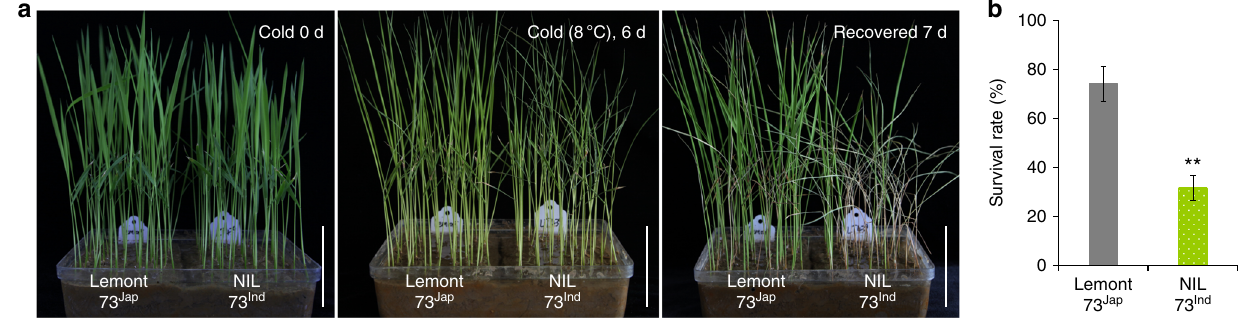
Fig. 4 Increased sensitivity of bZIP73 Ind near-isogenic lines to cold stress. a Cold treatment of bZIP73 Ind near-isogenic lines (NIL) and Lemont ( japonica ) at 8 °C for 6 days and recovery (Recovered) at 28 °C for 7 days. NIL is introgression of bZIP73 Ind into the japonica variety Lemont. b Survival rates of Lemont and NIL after recovery from cold treatment. All data were collected with three biological replicates ( n = 120 each). Error bar, standard deviation. Scale bars, 5 cm; ** p < 0.01, two-tailed t -test in comparisons to the control (Lemont)